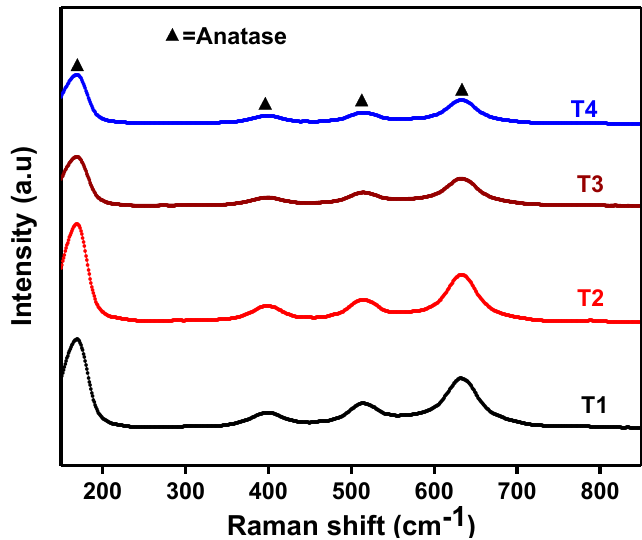
Figure 2. Raman spectra of the colored TiO 2 nanoparticles (NPs) prepared at various glycerol concentrations and calcined at 300 °C.